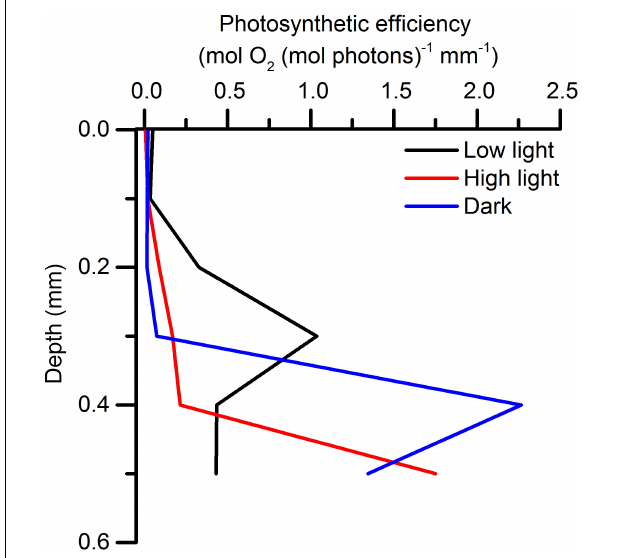
FIGURE 6 | Photosynthetic efficiencies [in mol O 2 (mol photons) − 1 mm − 1 ] calculated from volume-specific gross photosynthesis rates and the photon scalar irradiance incident to the corresponding depth in a low light-, high light-, and dark-acclimated biofilm (means; n =